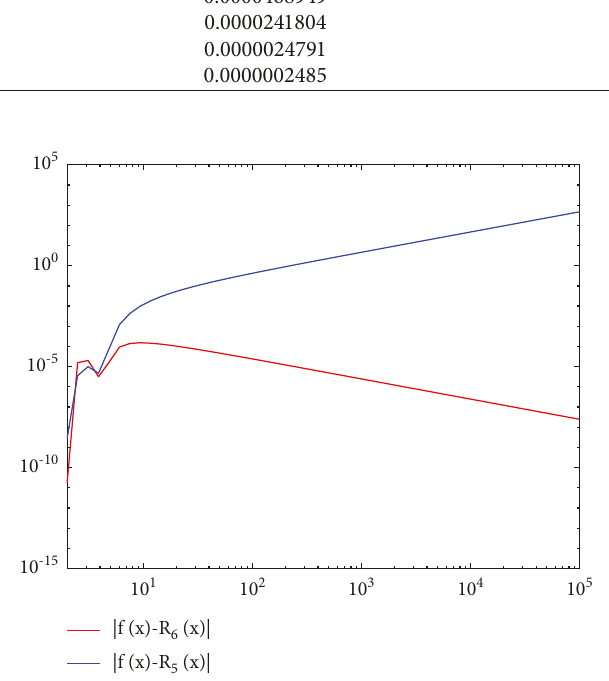
Figure 6: Function plots of | f ( x ) − R